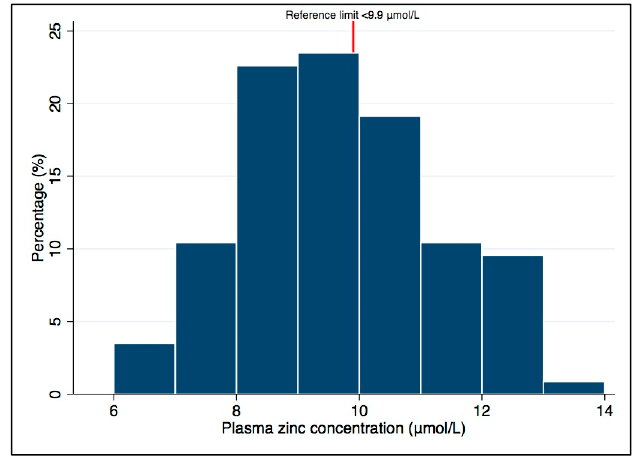
Figure 1. Plasma zinc concentrations ( μ mol/L) of participants ( n = 115).